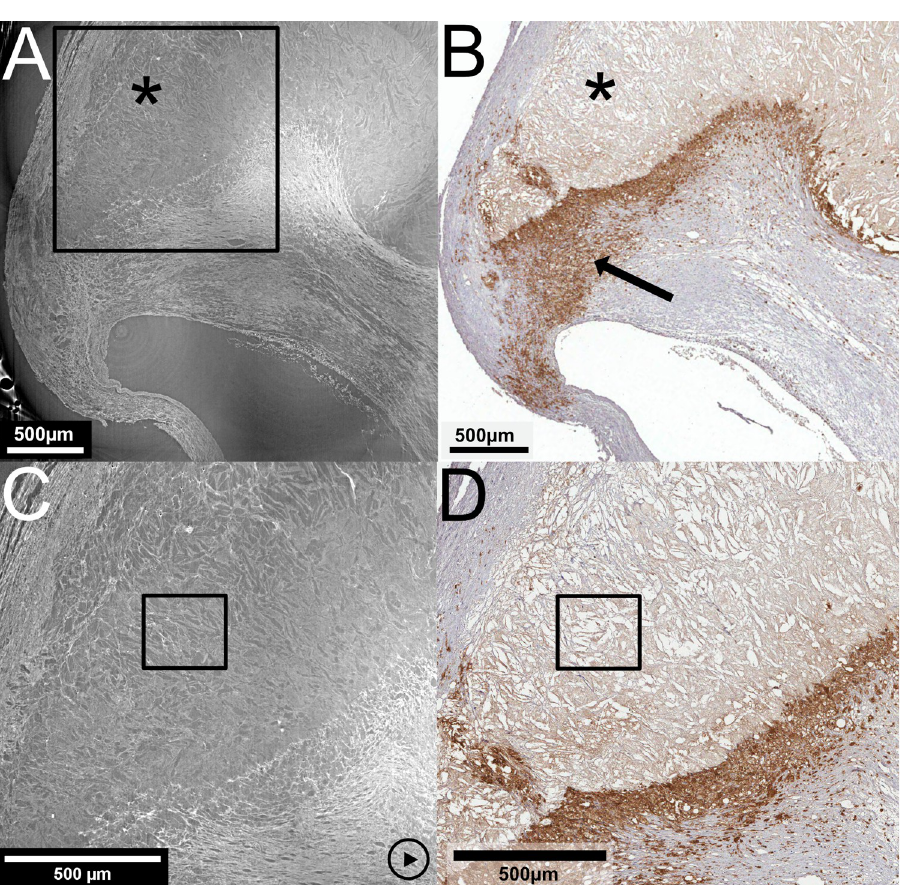
Fig 5. Plaque with lipid rich necrotic core (LRNC) and with cholesterol crystals. LRNC depicted with stitched HR SR μ CT (A) and histology stained for macrophage with CD68 (B) . A part of the LRNC is indicated with asterisks ( � ). The black arrow in (B) points to a region dense with macrophages. (C) and (D) are zoomed in and marked with squares representing regions rich in cholesterol crystals. The "play" symbol in (C) : movie material (S9 Movie in S1 File) showing the HR tomographic image stacks of the LRNC with focus on the cholesterol crystals. Plaque ID 2 in S1 Table in S1